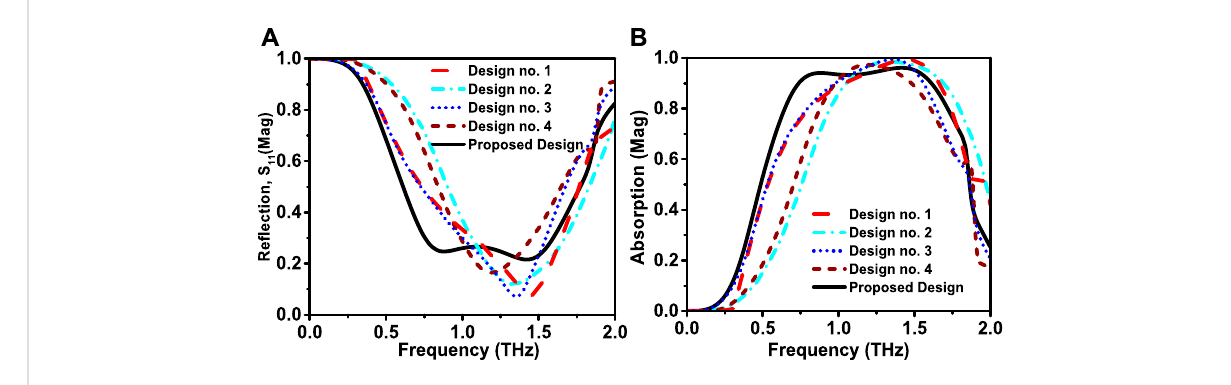
FIGURE 3 The simulated results of (A) re fl ection (S 11) and (B) absorption as a function of frequency for different